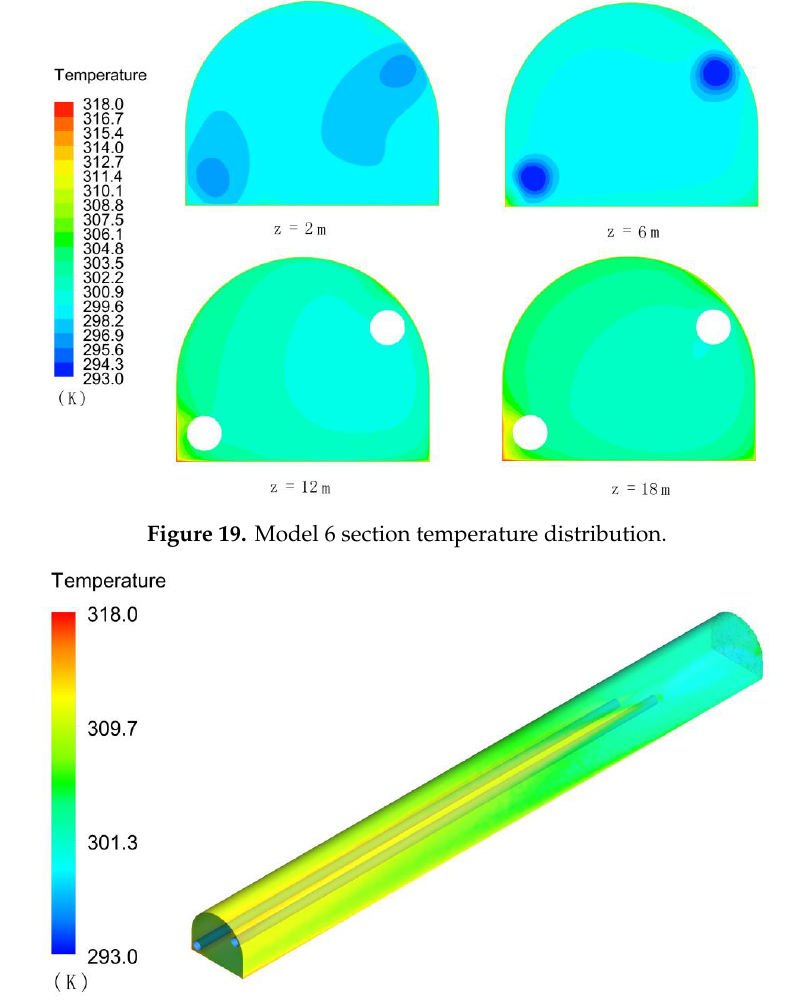
Figure 18. Three-dimensional distribution of Model 5 roadway temperature.